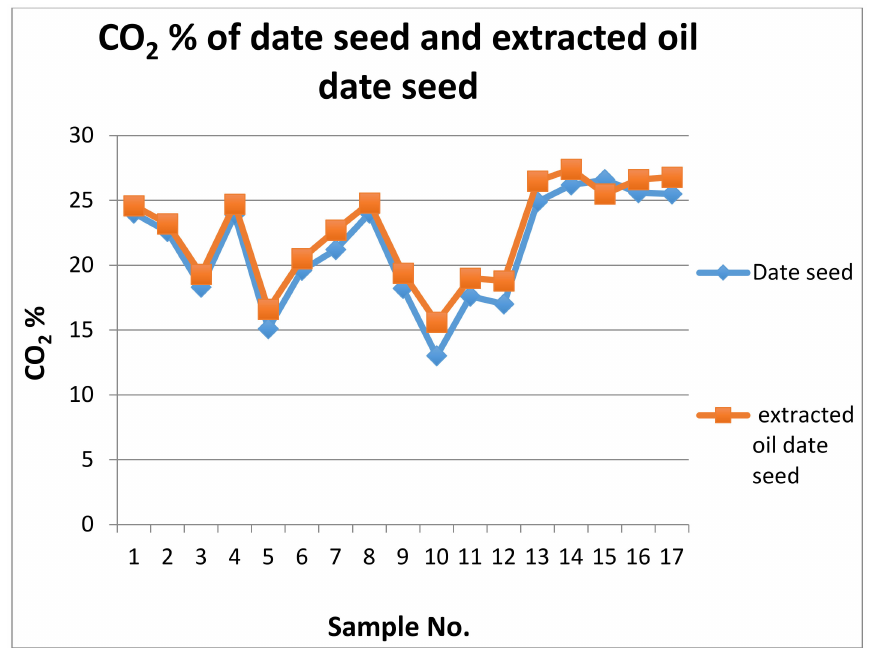
Figure 41. The alteration in CO 2 % between date seed and extracted oil date